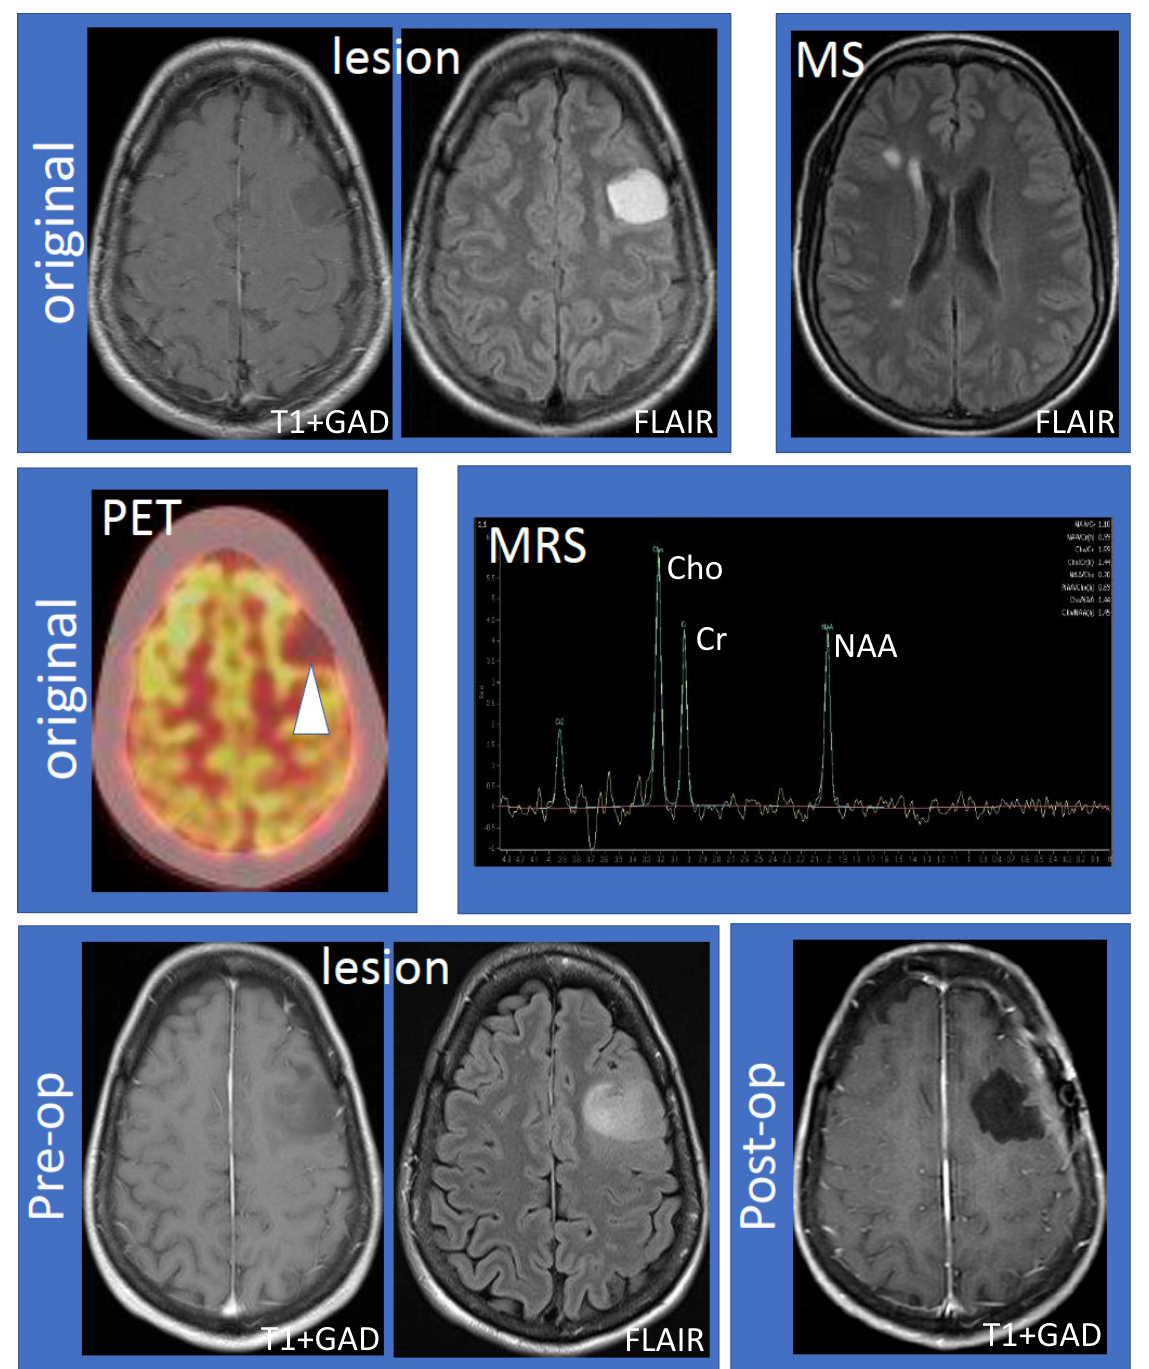
Figure 1. Work-up and progression of the left frontal lobe lesion. The top row shows the large, non-enhancing lesion distinct from MS lesions (left to right: T1 following gadolinium administration (T1 + GAD) and fluid attenuated inversion recovery (FLAIR) showing the lesion; FLAIR showing MS lesions). The middle row shows hypometabolism of the lesion using fluorodeoxyglucose positron emission tomography–computed tomography imaging and results of magnetic resonance spectroscopy (MRS). MRS values are as follows: N-acetylaspartate (NAA)/creatine (Cr) 1.10, NAA/Cr(h) 0.99, choline (Cho)/Cr 1.59, Cho/Cr(h) 1.44, NAA/Cho 0.70, NAA/Cho(h) 0.69, Cho/NAA 1.44, and Cho/NAA(h) 1.45. The bottom row shows that the lesion increased in size compared to the original MRI (“pre-op”) and successful resection of the lesion (“post-op”). Abbreviations: MS: multiple sclerosis; PET: positron emission tomography; MRS: magnetic resonance spectroscopy; Pre-op: pre-operative; Post-op: